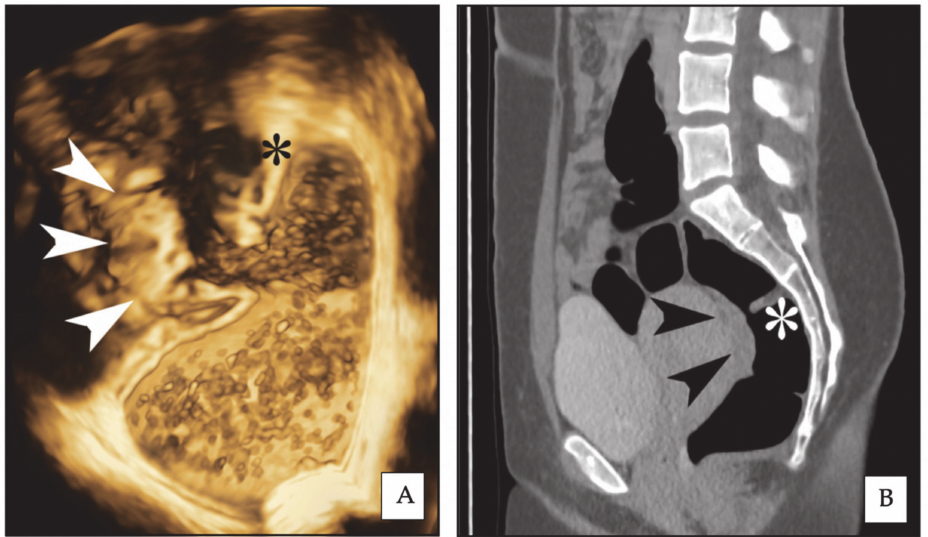
Figure 1. Same rectal endometriotic nodule (arrowheads) is shown in three-dimensional rectal water contrast transvaginal ultrasonography (3D-RWC-TVS) ( A ) and computed tomographic colonography (CTC) ( B , sagittal plane). The asterisk indicates the same rectal Houston’s valve. The nodule has largest diameter of 2.6